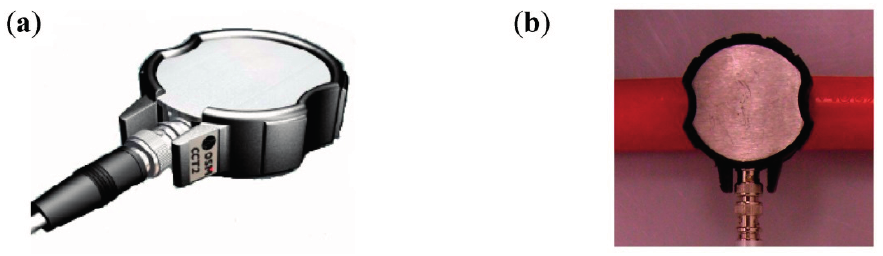
Figure 8. ( a ) UHF non-invasive patch coupler; ( b ) Sensor installed on the surface of a power